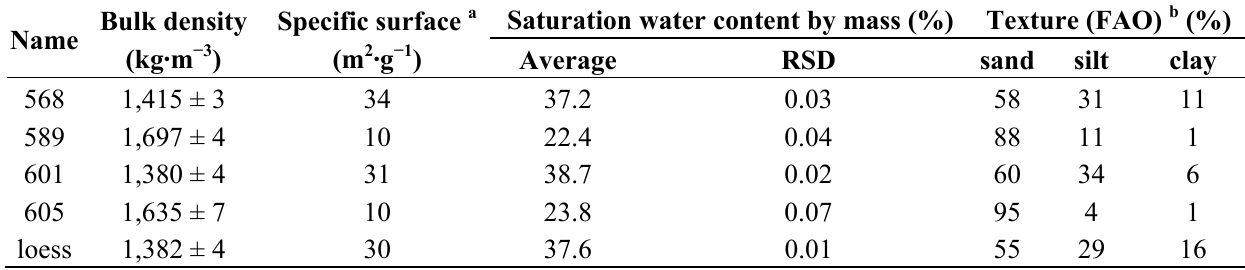
Table 1. Selected physical characteristics of tested material; RSD stands for relative standard deviation (standard deviation/mean